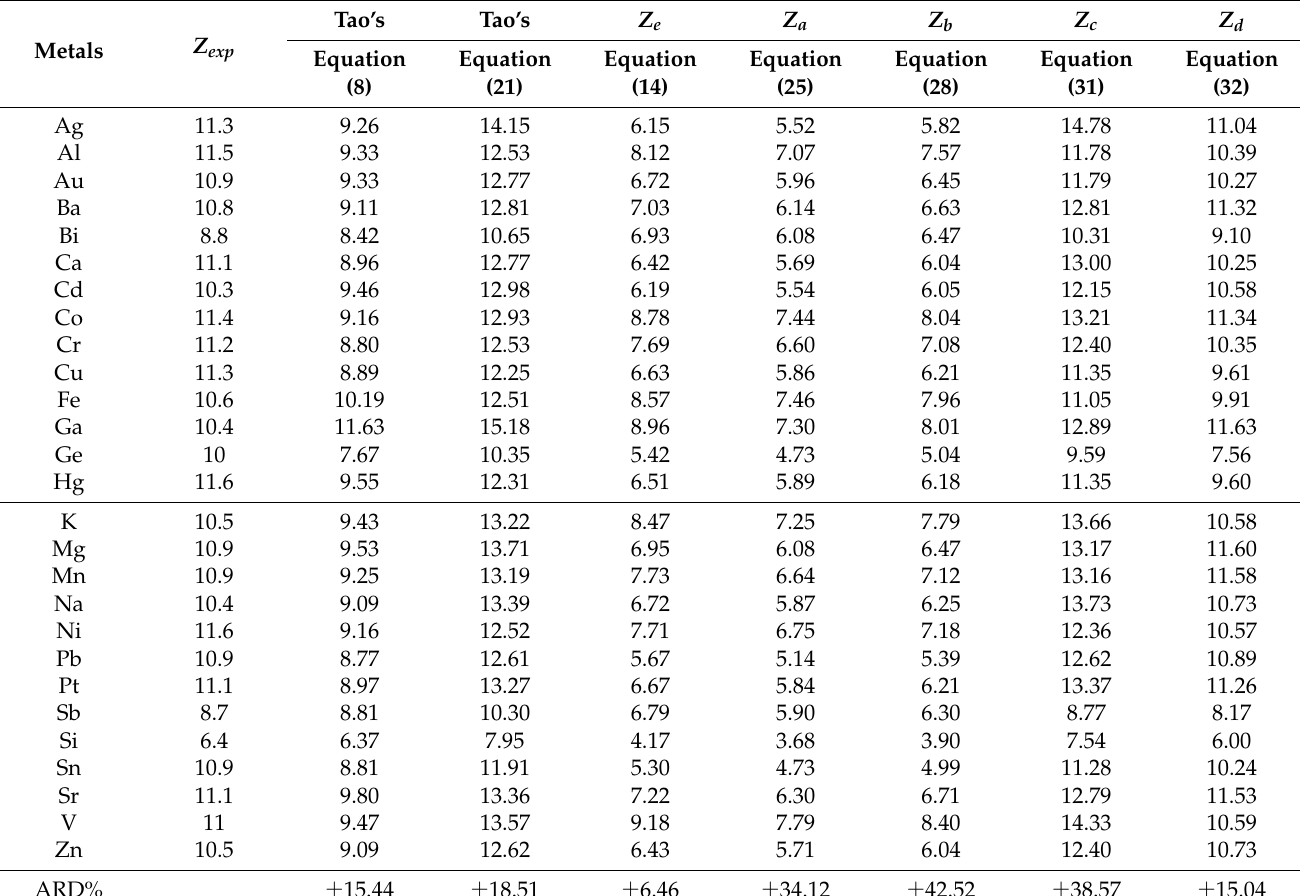
Table 2. The 27 coordination numbers of liquid metals calculated by 7